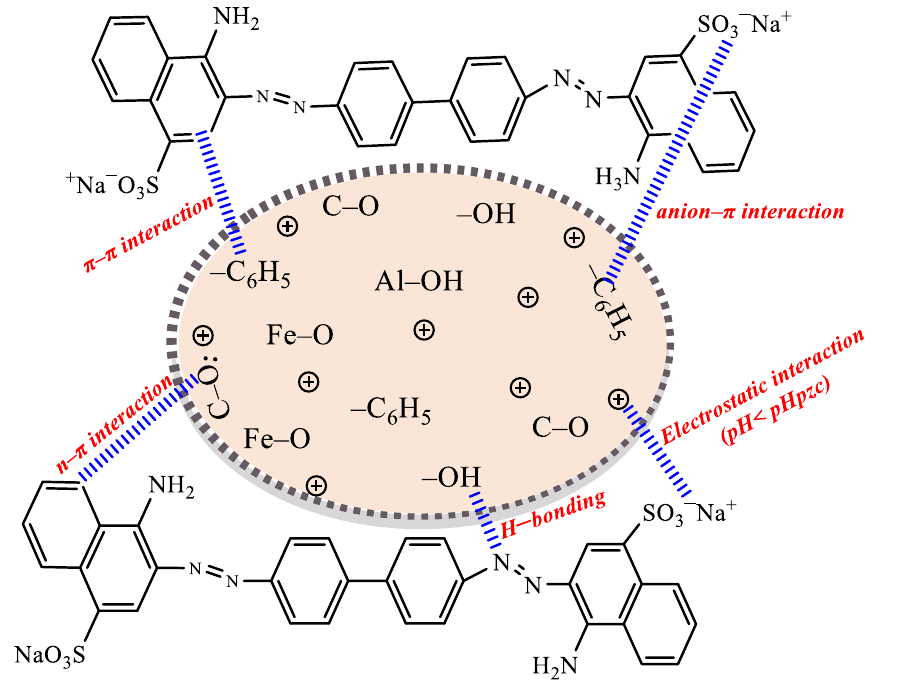
Figure 3. Proposed mechanisms of adsorption of Congo red by